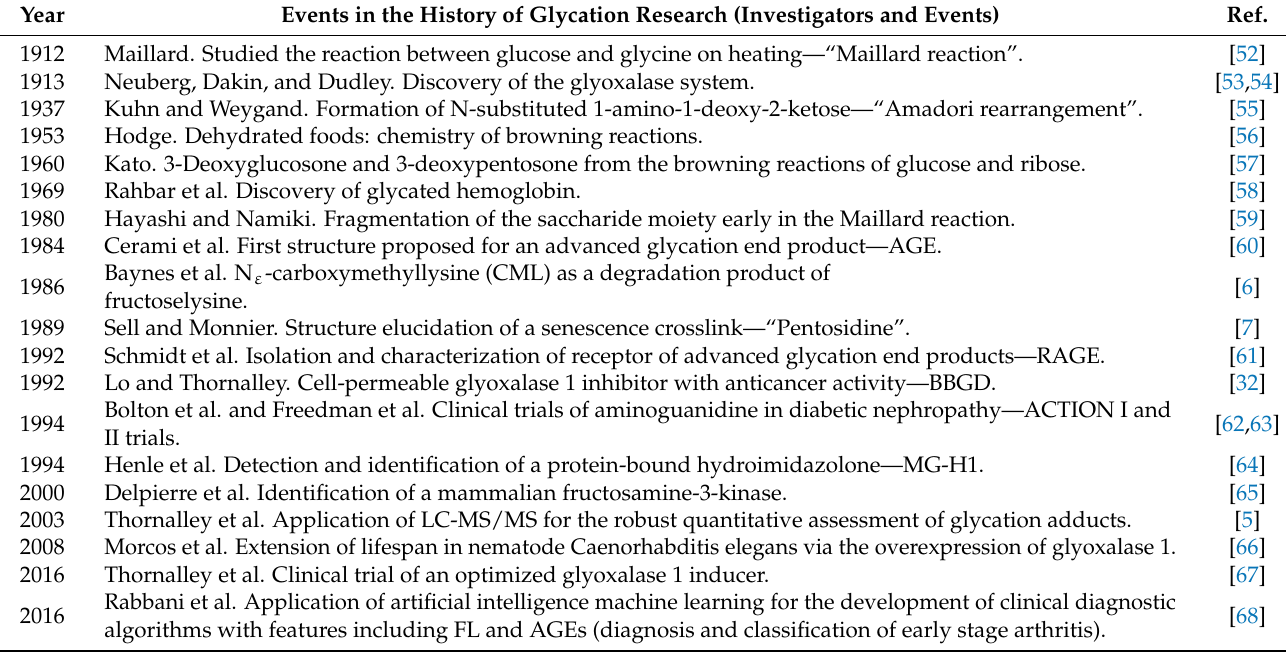
Table 1. Key events in the history of glycation research—a personal view. Events in the History of Glycation Research (Investigators and Events)